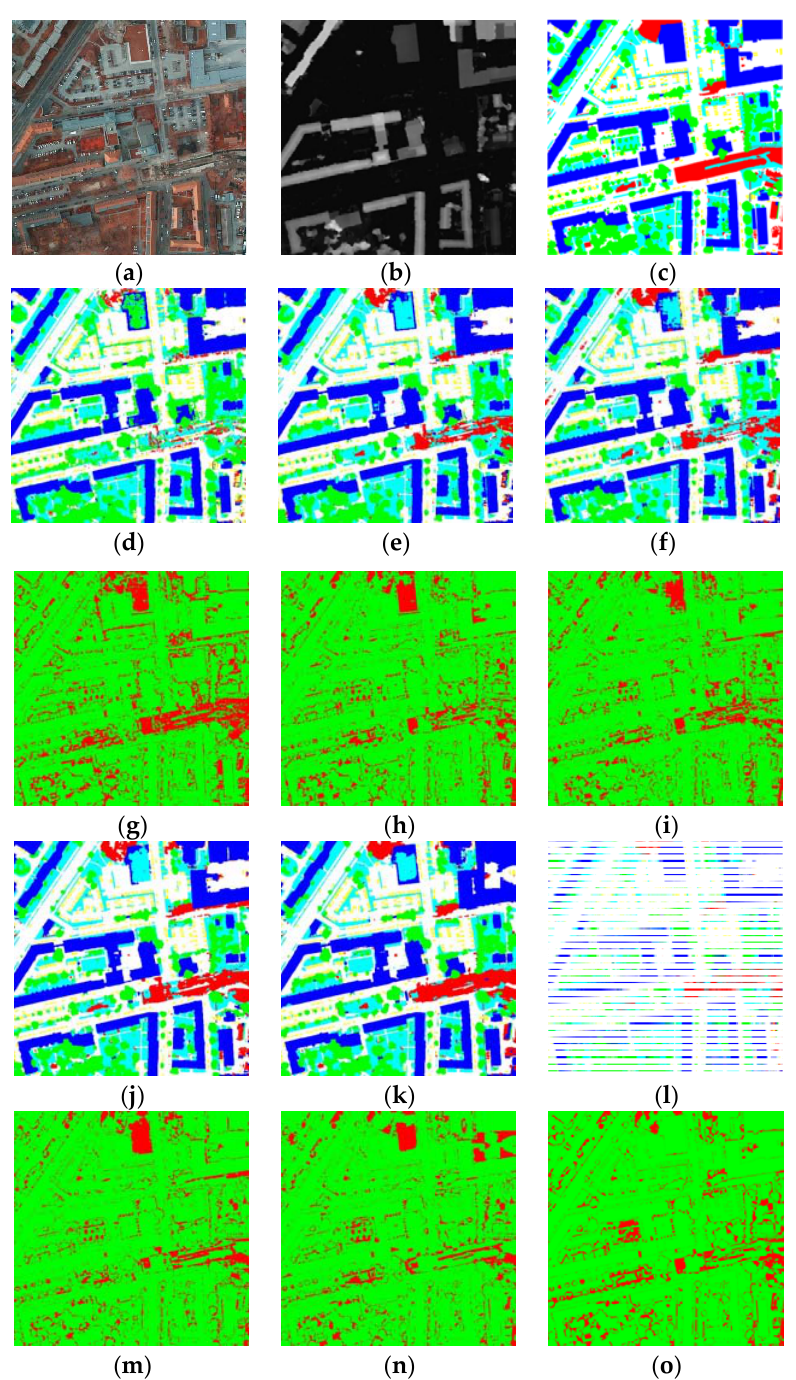
Figure 7. Qualitative comparison with other competitors’ methods on ISPRS Potsdam challenge online test set. The label includes six categories: impervious surface (white), building (blue), low vegetation (cyan), tree (green), car (yellow) and clutter/background (red). ( a ) TOP tile; ( b ) nDSM; ( c ) ground truth; ( d–f ) prediction results of ‘UZ_1’, ‘RIT_L7’ and ‘RIT_2’; ( g–i ) red ‐ green maps of ‘UZ_1’,